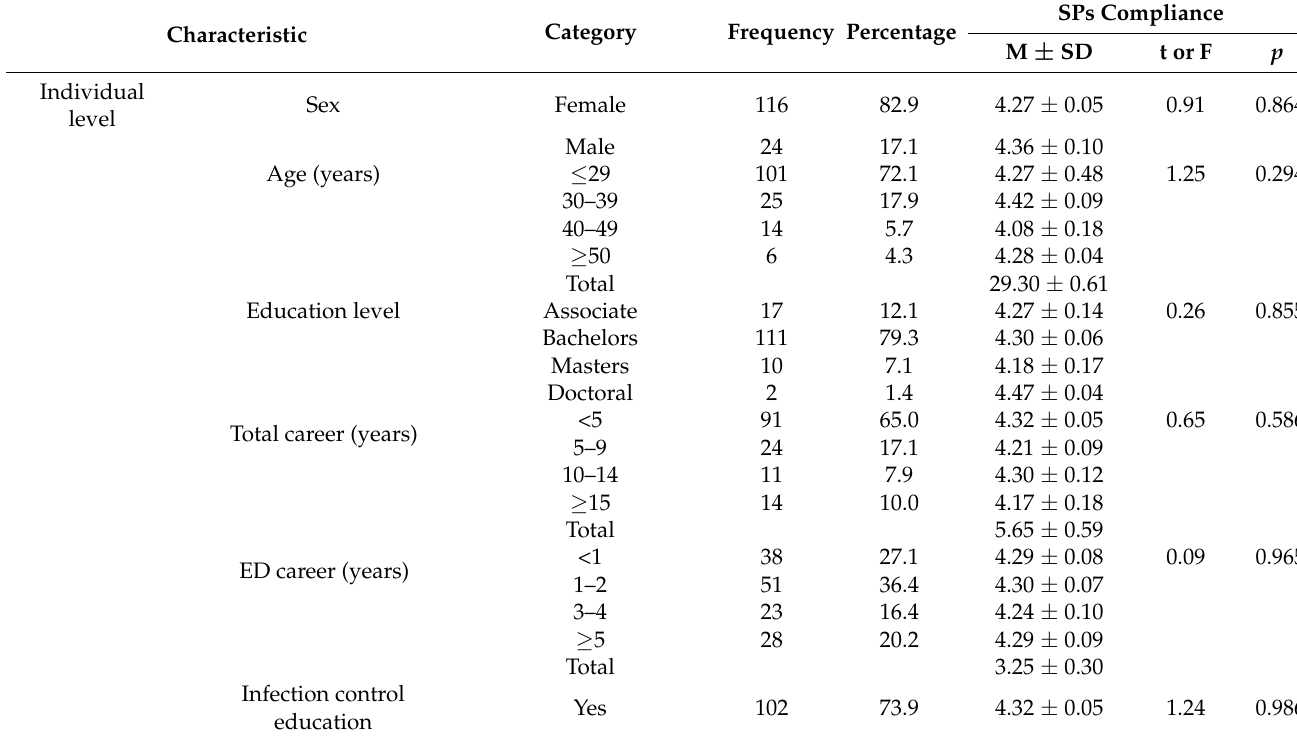
Table 1. Differences in compliance with SPs according to general characteristics, infection-control-related characteristics, and organizational features (N =